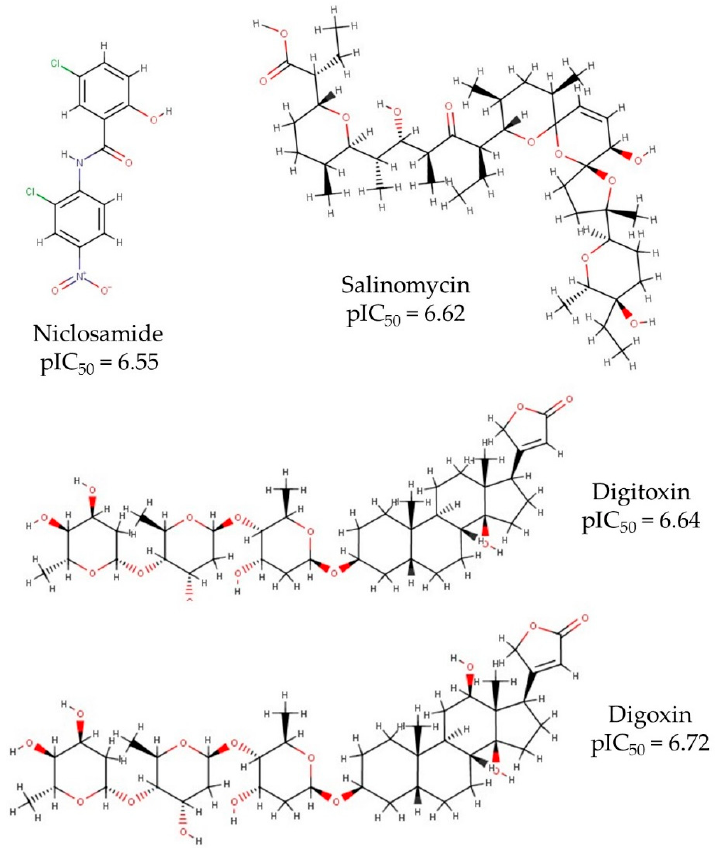
Figure 1. Four most potent antiviral candidates, based on experimental pIC 50 values.